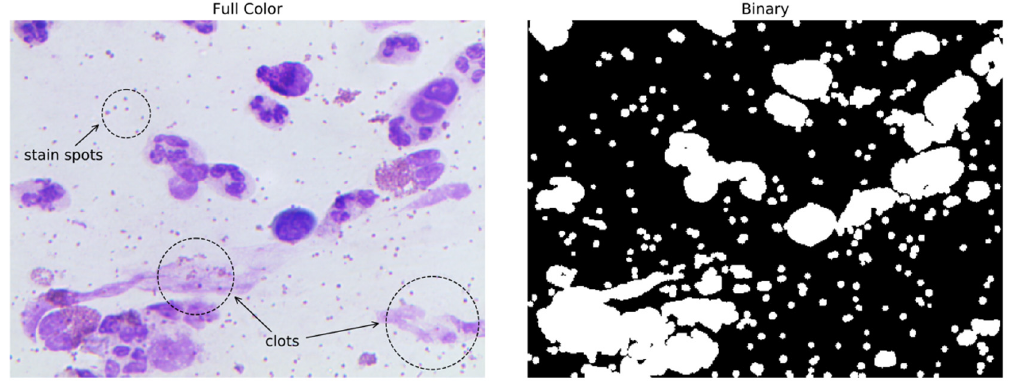
Figure 5. An example of a full-color field image (input) and binarized version (output) used in the field density extraction algorithm.